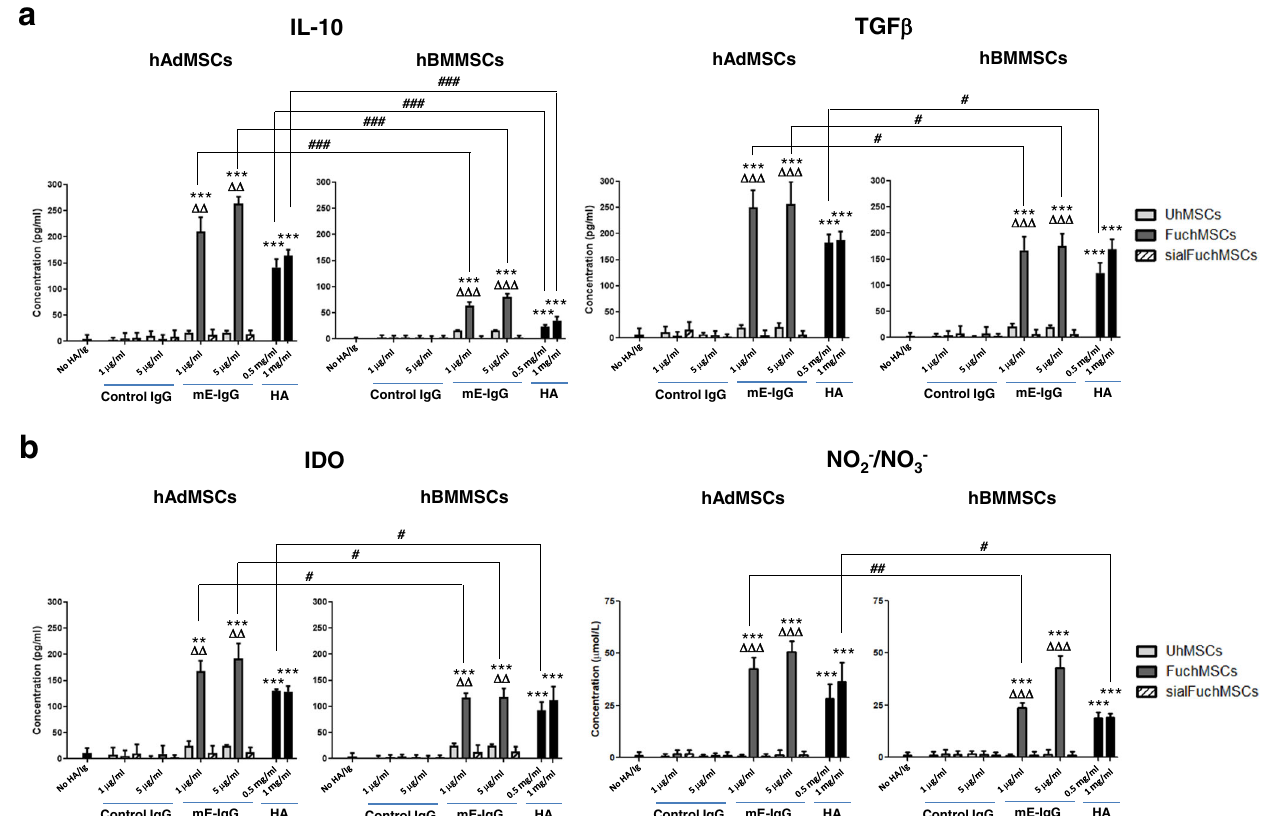
Fig. 7 Effects of HCELL/CD44 engagement on immunomodulatory properties of human MSCs. Human MSCs derived from adipose tissue (hAdMSCs) or bone marrow (hBMMSCs) were fucosylated ( “ Fuc ” : FuchAdMSCs or FuchBMMSCs) or buffer-treated (unmodi fi ed ( “ U ” ): UhAdMSCs or UhBMMSCs) and cultured in presence of different concentrations of E-selectin (mE-Ig) or hyaluronic acid (HA) for 3 days at 37 °C. Thereafter, culture supernatants were harvested and analyzed by ELISA for a levels of anti-in fl ammatory molecules interleukin-10 (IL-10) and TGF β , or b IDO and NO metabolites (e.g., NO 2 − /NO 3 − ). Cells cultured in the absence of HA or in presence of control IgG served as negative controls. Also, as controls to assess speci fi city of E-selectin binding, FuchAdMSCs or FuchBMMSCs were treated with sialidase ( “ sialFuchAdMSCs ” or “ sialFuchBMMSCs ” ) to cleave terminal sialic acid from sLe x (thereby abrogating binding to E-selectin). As shown in panels, levels of analyzed immunomodulatory molecules signi fi cantly increased following hMSC co-incubation with either E-selectin or